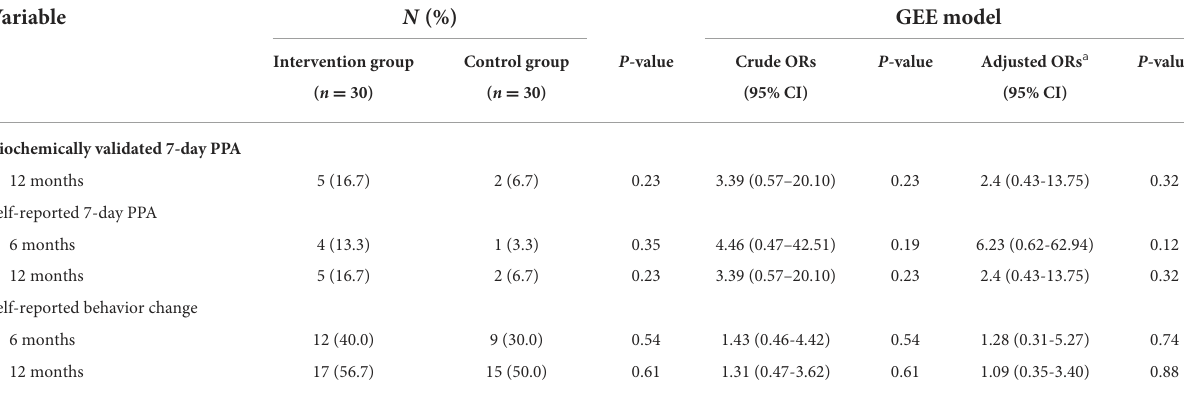
TABLE 3 The outcomes of participants in the intervention and control groups at 6 and 12 months. Variable